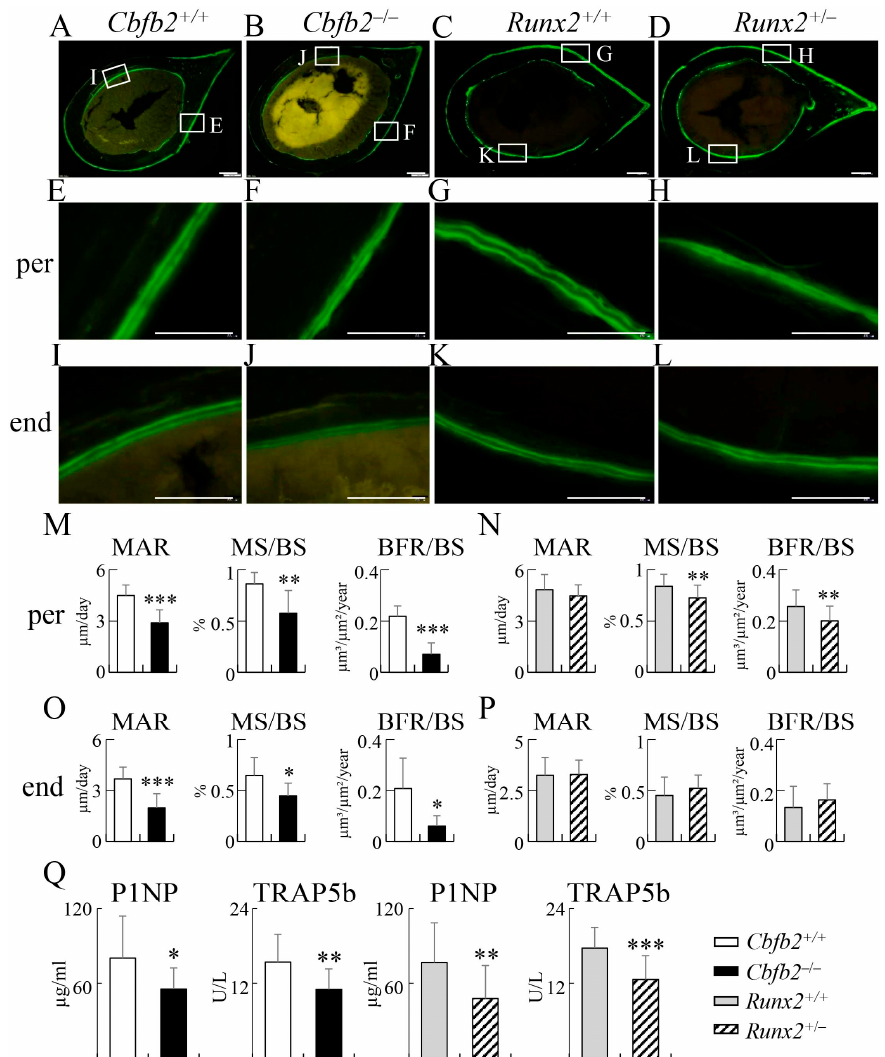
Figure 13. Dynamic bone histomorphometric analysis of cortical bone at the mid-diaphyses of femurs and serum markers for bone formation and resorption in male mice at 10 weeks of age. ( A – L ) Cross-sections of Cbfb2 +/+ ( A , E , I ), Cbfb2 –/– ( B , F , J ), Runx2 +/+ ( C , G , K ) and Runx2 +/– ( D , H , L ) mice, into which calcein was injected twice. The boxed regions in ( A – D ) are magnified in ( E , I , F , J , G , K , H , L ), respectively. Scale bars: 200 μ m ( A – D ) and 100 μ m ( E – L ). ( M – P ) Mineral apposition rate (MAR), mineralizing surface (MS/BS) and bone formation rate (BFR/BS) in the periosteum ( M , N ) and endosteum ( O , P ) of Cbfb2 +/+ and Cbfb2 –/– mice ( M , O ) and Runx2 +/+ and Runx2 +/– mice ( N , P ). Cbfb2 +/+ , n = 8; Cbfb2 –/– , n = 8; Runx2 +/+ , n = 22; Runx2 +/– , n = 21. ( Q ) Serum markers for bone formation (P1NP) and resorption (TRAP5b). Data are shown as the mean ± SD. * p < 0.05, ** p < 0.01 and *** p < 0.001. The number of mice analyzed: Cbfb2 +/+ , n = 14; Cbfb2 –/– , n = 16; Runx2 +/+ , n = 20; Runx2 +/– , n = 18.